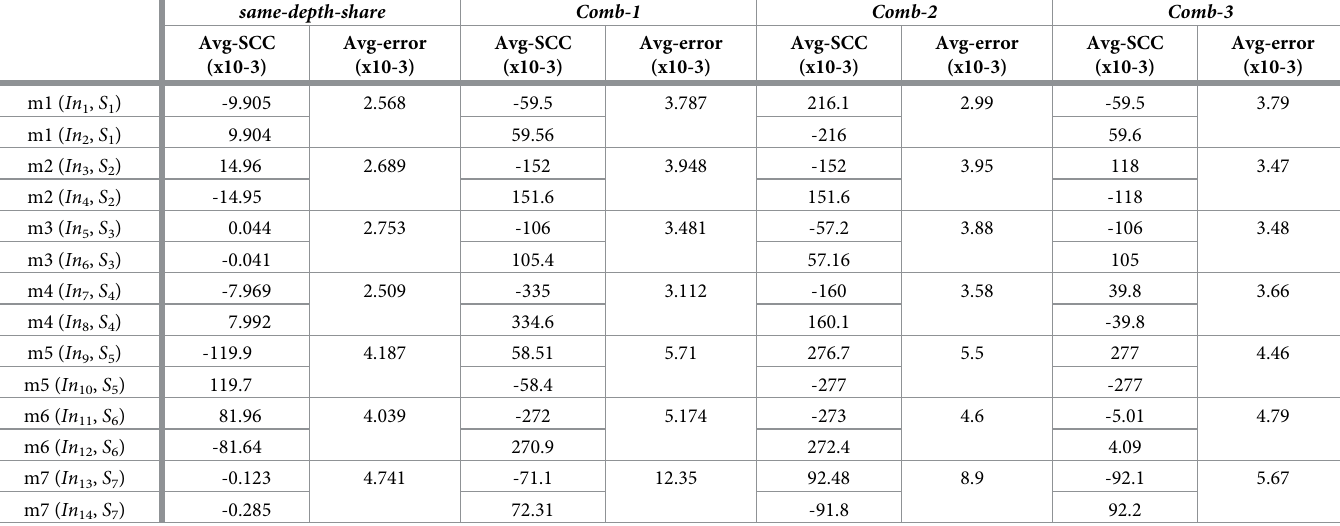
select lines can be chosen in such a way as to reduce the complexity of hardware and to main- tain the accuracy of filters by reducing the correlation between the values applied at the select lines. Therefore, in this work the possibility of applying uniform patterns are explored for these select lines, e.g. ‘11111....0000....00’ or ‘010101....00000....00’ or ‘00110011....00000....00’ etc. (pattern with 1’s in the beginning and 0’s in the end) and the shifted version of these e.g. ‘00000...11111....11’ etc., which are less complex to generate. It should be noted here that the patterns other than continuous 1’s and 0’s can only be applied in case where the value of select line is less than or equal to 0.5. The effect of using the mixture of these patterns on the error performance of different order FIR filters is analyzed. According to the theorems given in the previous section, the correlation error at the output of SC-based FIR filters depends upon two factors, 1) correlation between the select lines and the inputs of MUX and, 2) correlation between the select lines of different MUXes that are mutually reachable. The effect of these cor- relations for the case of uniform patterns is analyzed. The conventional and SC-based 7 th order FIR filter are implemented for error performance analysis. A floating point implementa- tion of the conventional filter is done, whereas, for SC-based filters the input samples are rep- resented as 8-bit fixed point numbers. Two cases of SC-based FIR filters are implemented, 1) same-depth-share case [8] and, 2) Uniform patterns case. For Uniform patterns case, the con- stant patterns are applied for all the select lines of MUXes and random patterns, using a single LFSR, for the inputs of filter. A set of 2000 samples of bird sound signal is applied to the filter. Specifically, the different combinations of Uniform patterns that are analyzed are as follows: Comb-1 : A pattern of continuous one’s and zero’s i.e. ‘1111 . . . .0000 . . . .’ are applied to the select line of all MUXes and therefore, the correlation between the select lines is 1. Table 1 shows the average correlation between the inputs and select line of each MUX and the average absolute error at the output of each MUX. The error is measured by calculating the absolute difference at the output of each MUX from the floating point conventional filter and taking the average over all 2000 samples. For comparison, the results are also given for the same- depth-share case. The initial seed values of all LFSRs are different for the same-depth-share case. From the results it can be seen that the difference in average error for the first four Table 1. Average correlation between the inputs and select line of each MUX and the average absolute error at the output of each MUX. same-depth-share Comb-1 Comb-2